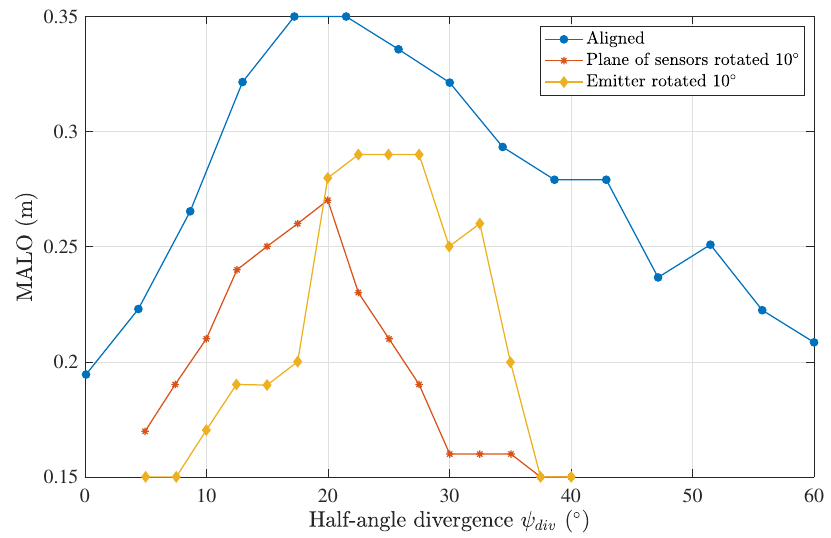
Figure 13. The MALO as a function of the divergence of the emitter for rotated communication links, considering a harbor II water type, a Tx–Rx distance of 0.5m and a 7-lens